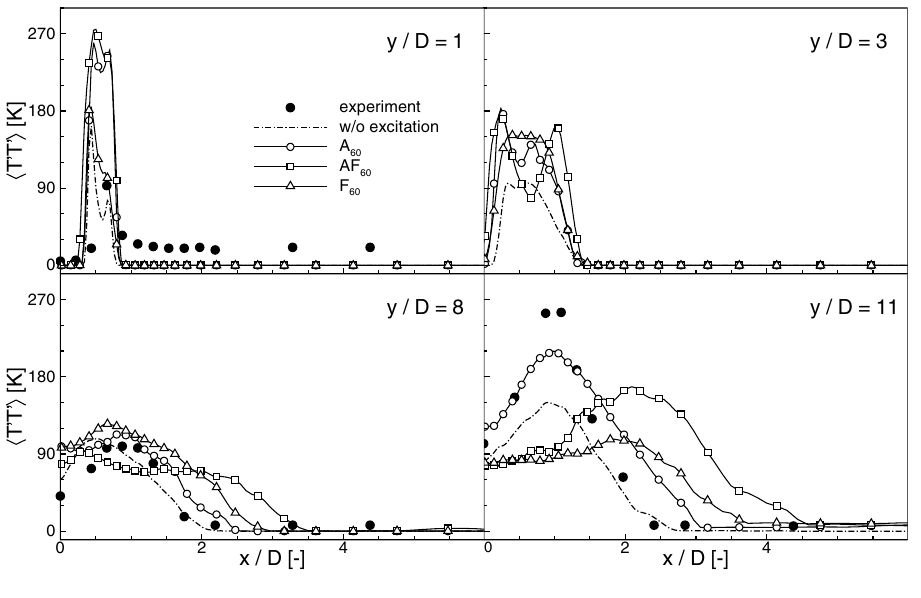
Figure 8. Temperature fluctuation profiles for St a